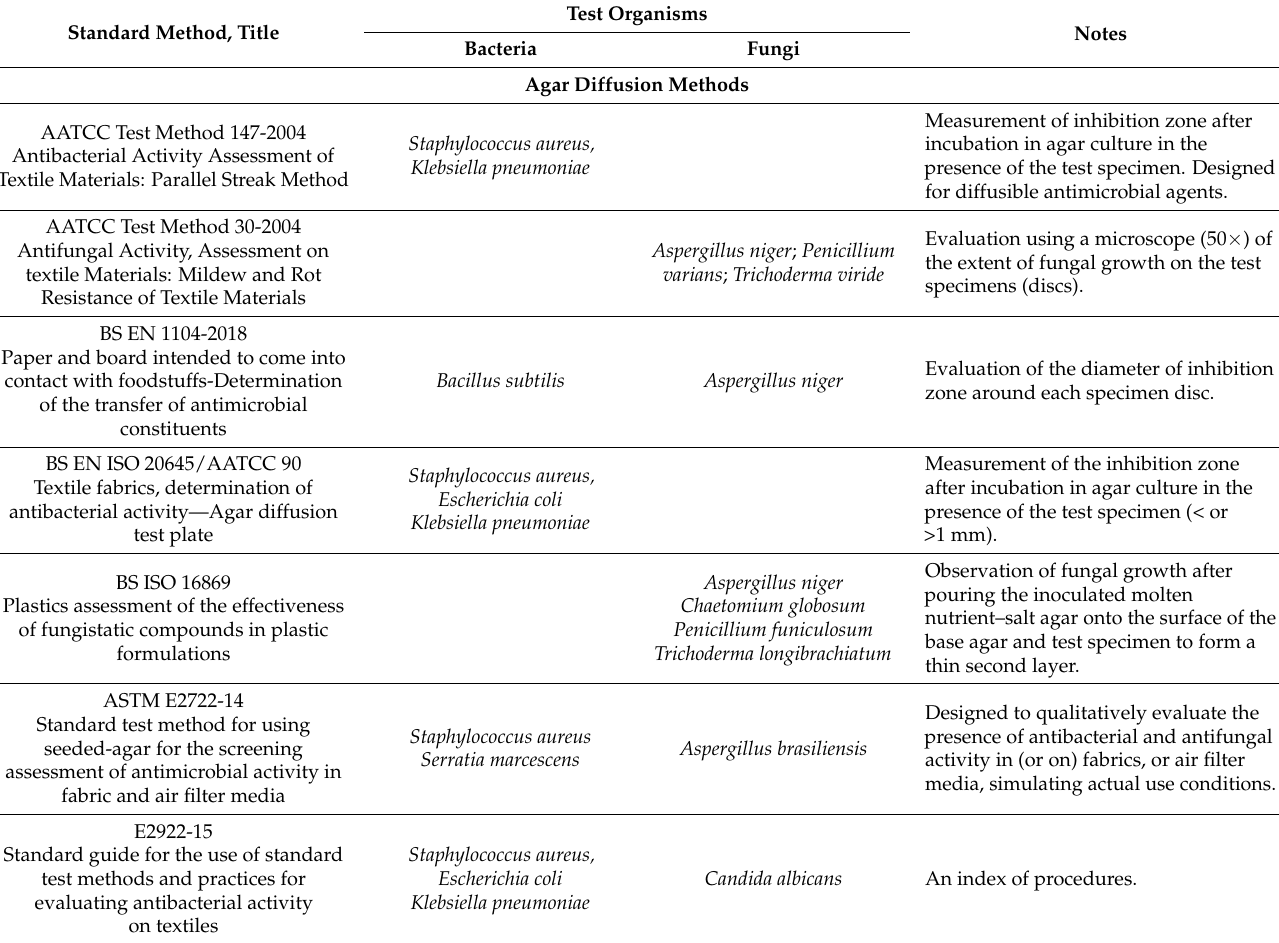
Table 1. Schematic description of selected standard methods for antimicrobial susceptibility of